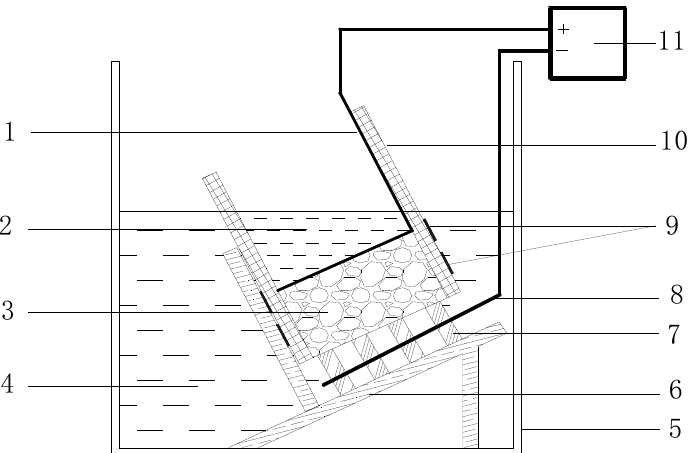
Figure 1. Test arrangement of the rapid chloride migration test (RCM). 1. Anode 2. Anolyte 3. Specimen 4. Catholyte 5. Plastice box 6. Plastic support 7. Cathod support 8. Cathod 9. stainless steel clamp 10. Rubber tube 11. Potential.